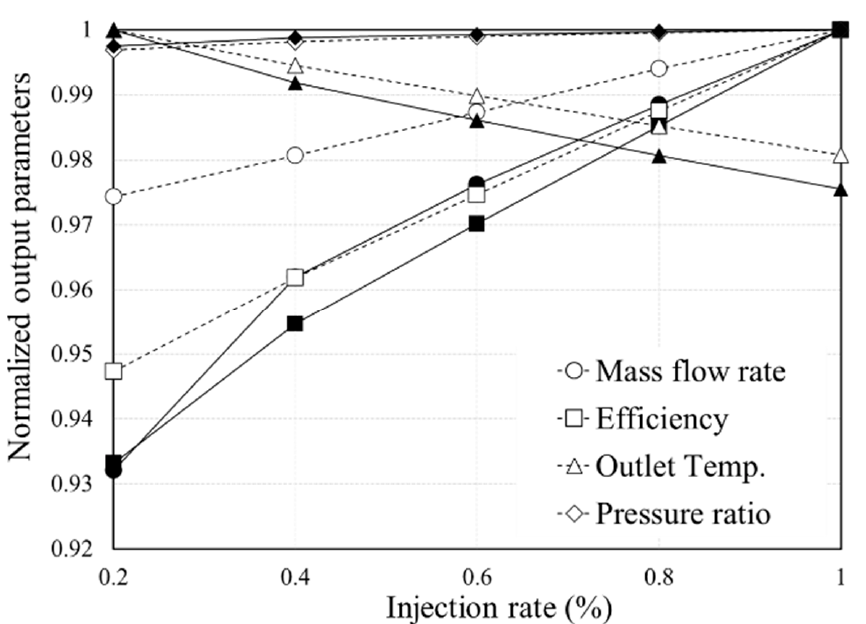
Figure 22. Effect of the different mass flow rate on the centrifugal compressor performance between the design point and surge region (Filled symbol: design point; open symbol: surge region) .